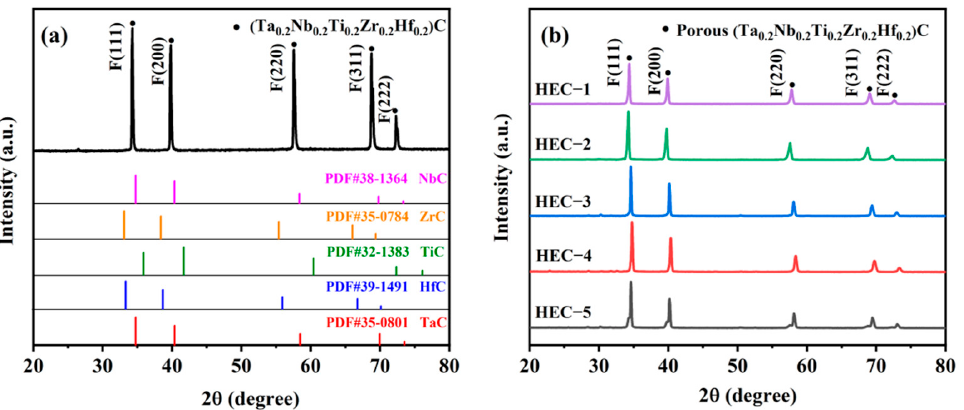
Figure 3. XRD patterns of obtained porous HECs: ( a ) comparison of HEC-1 sample with various carbides, ( b ) comparison of different porous HECs with various amount of pore-forming agent.